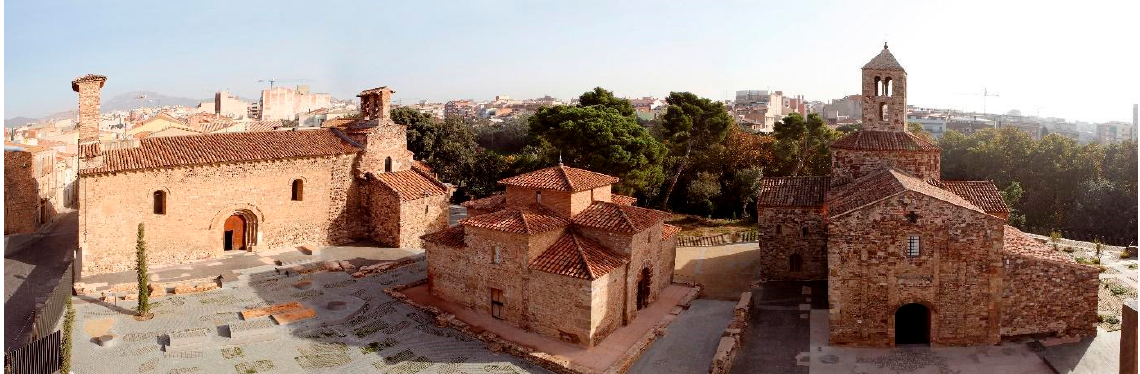
Figure 7. General view of the See of Egara with the church of Santa Maria de Terrassa on the right. © Photo: Badia/Casanova, Museu de Terrassa.